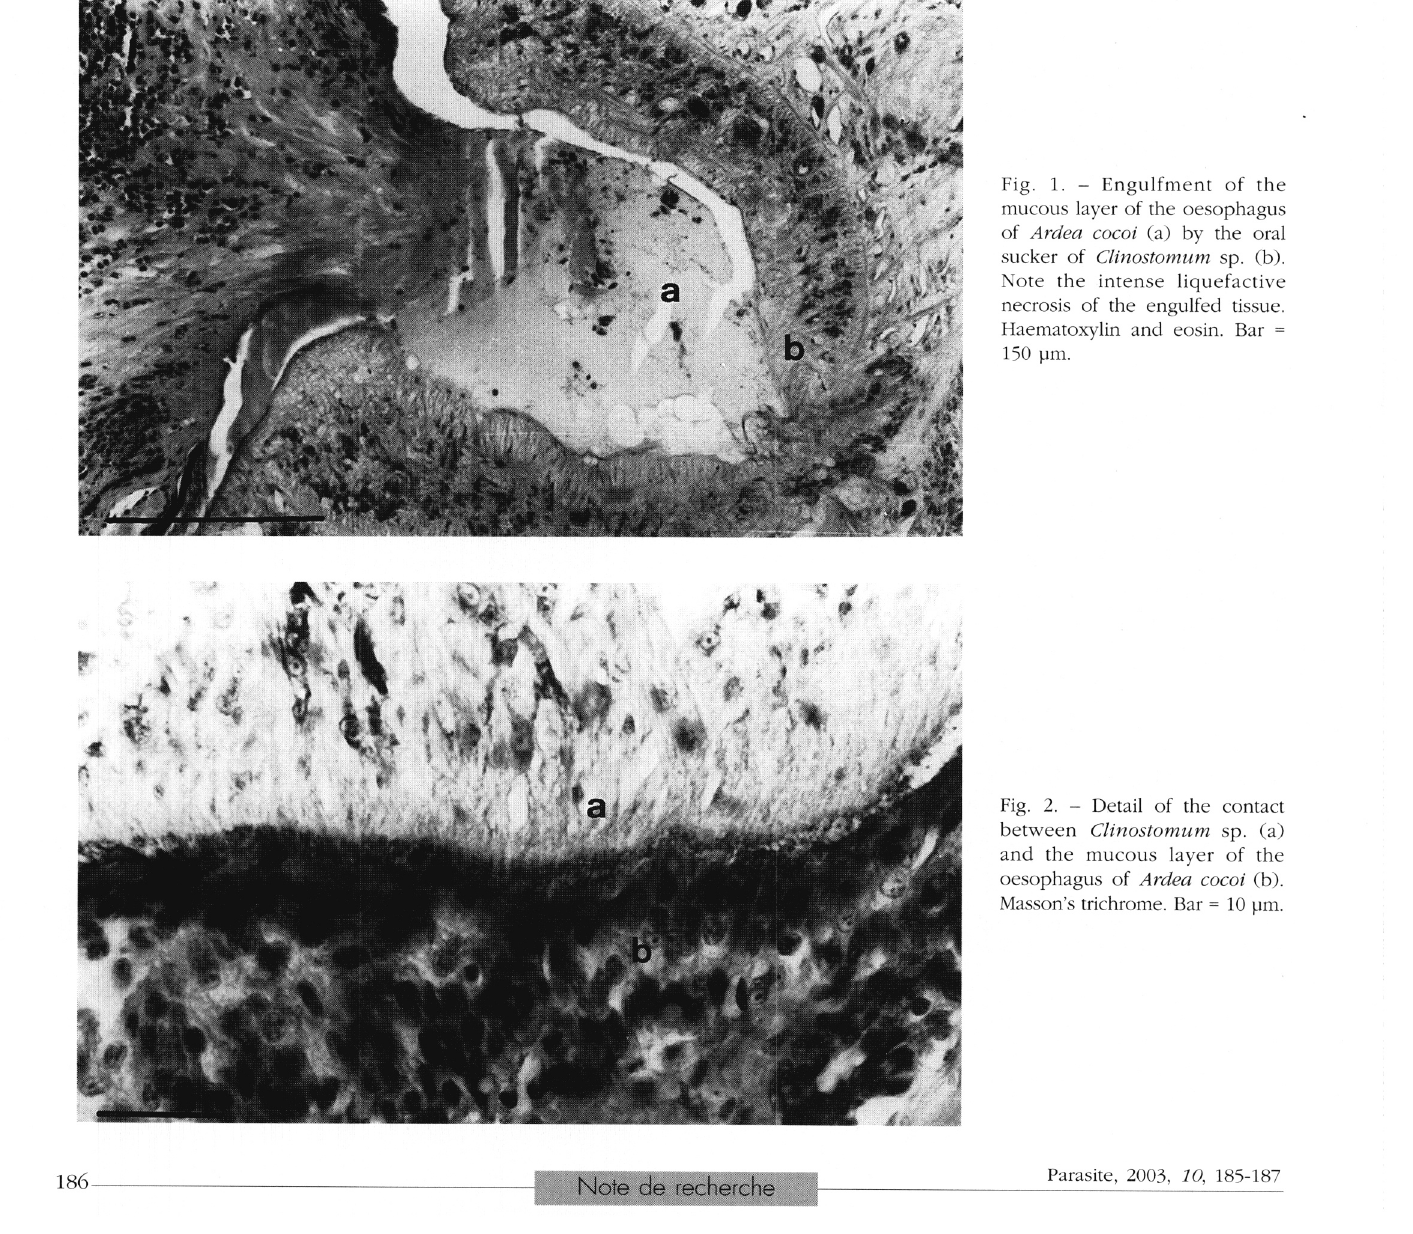
Fig. 1. - Engulfment of the mucous layer of the oesophagus